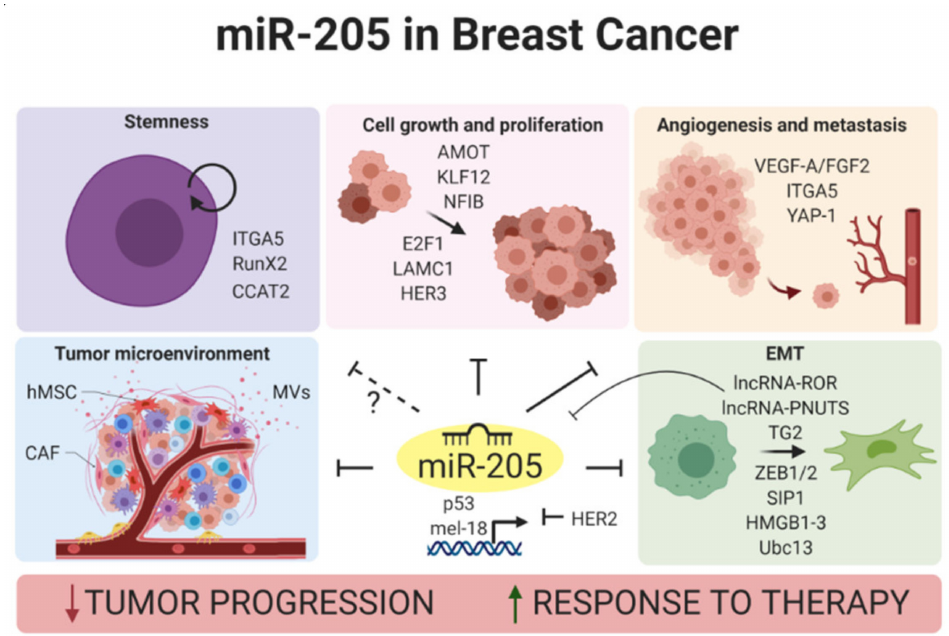
Figure 1. Overview of miR-205 oncosuppressive activity in breast cancer (created with